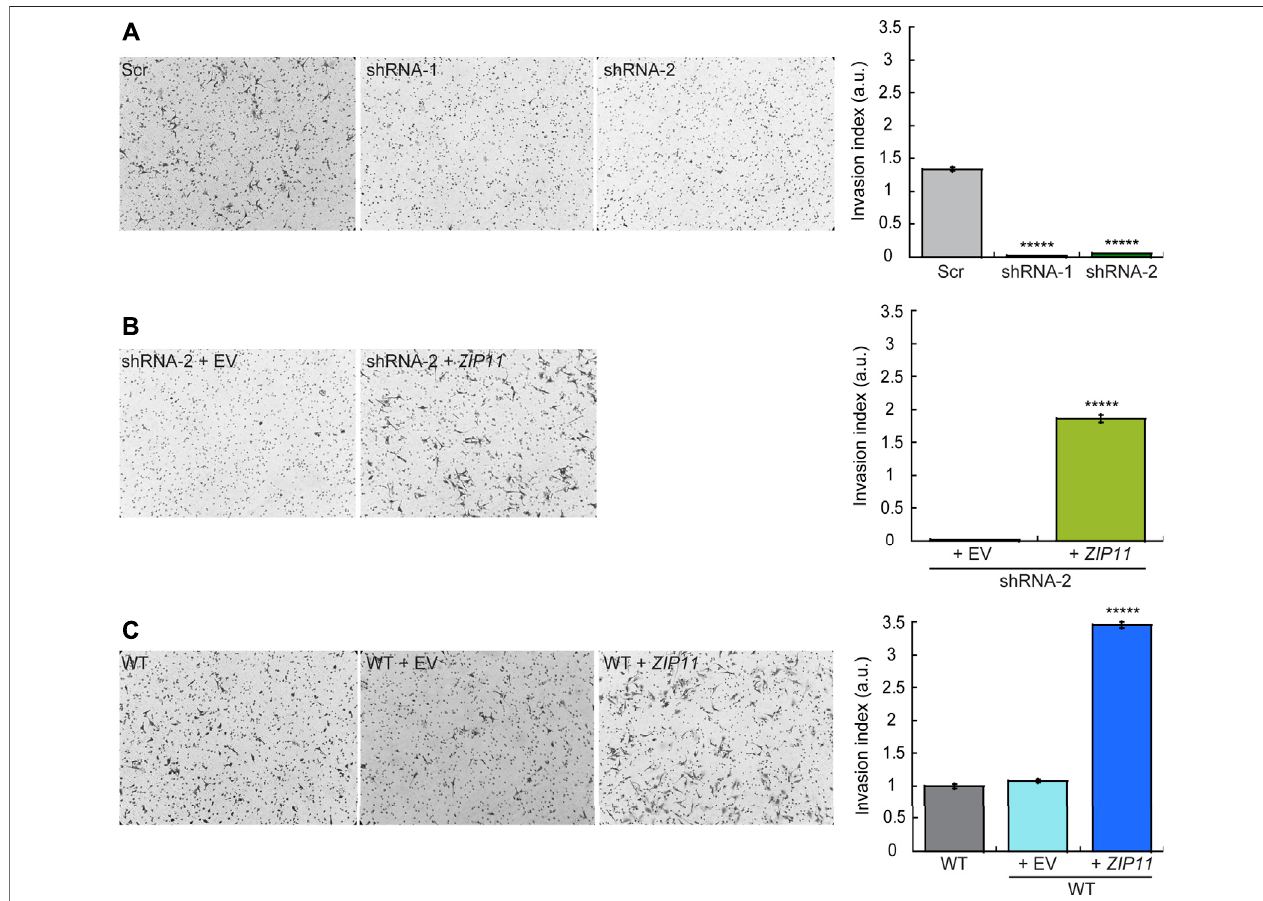
FIGURE 8 | ZIP11 is required for HeLa cells invasion through Matrigel. Representative light microscopy images (left panels) and quanti fi cation (right panels) of Matrigel invasion assay at 24 h for HeLa cells in which ZIP11 was KD (A) , reconstituted in the shRNA2 strain (B), or overexpressed in WT cells (C) . The data show the means±SEofthreeindependentbiologicalreplicatesimagedandareexpressedasthepercentageofinvadingcellscomparedtothecontrolshownintheplots.***** p <